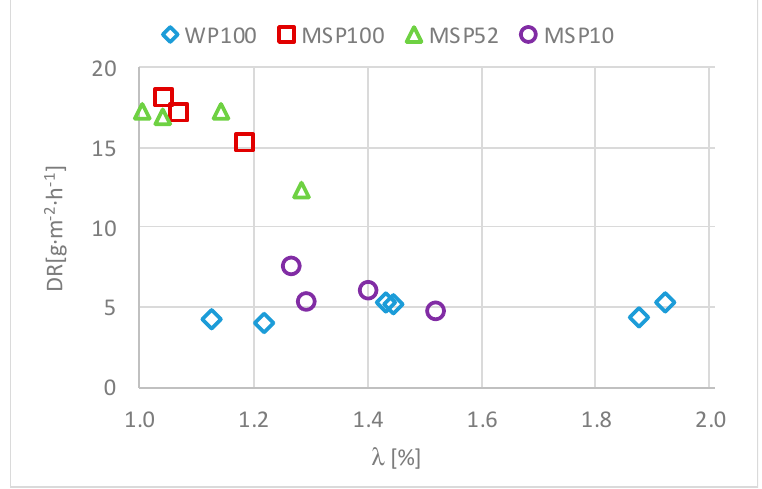
Figure 16. Deposition rate (DR) versus λ for the WP100 and MSP family.